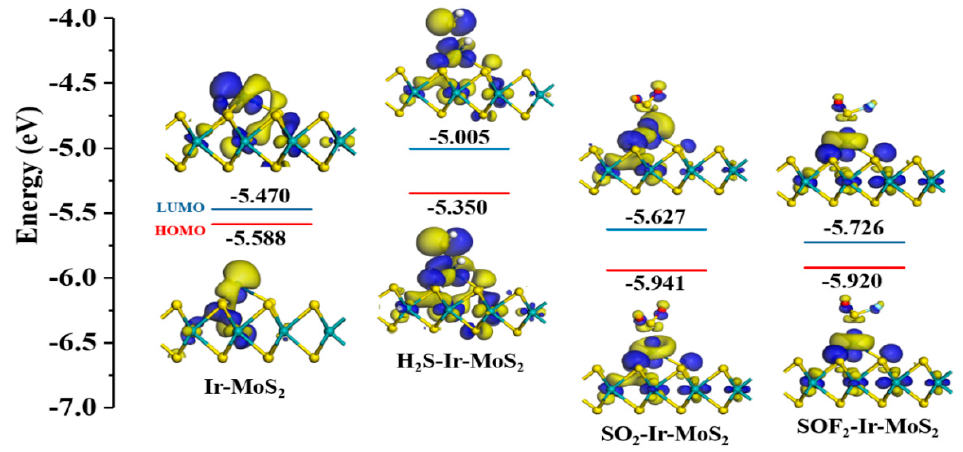
Figure 10. The HOMO and LUMO distributions of various systems.